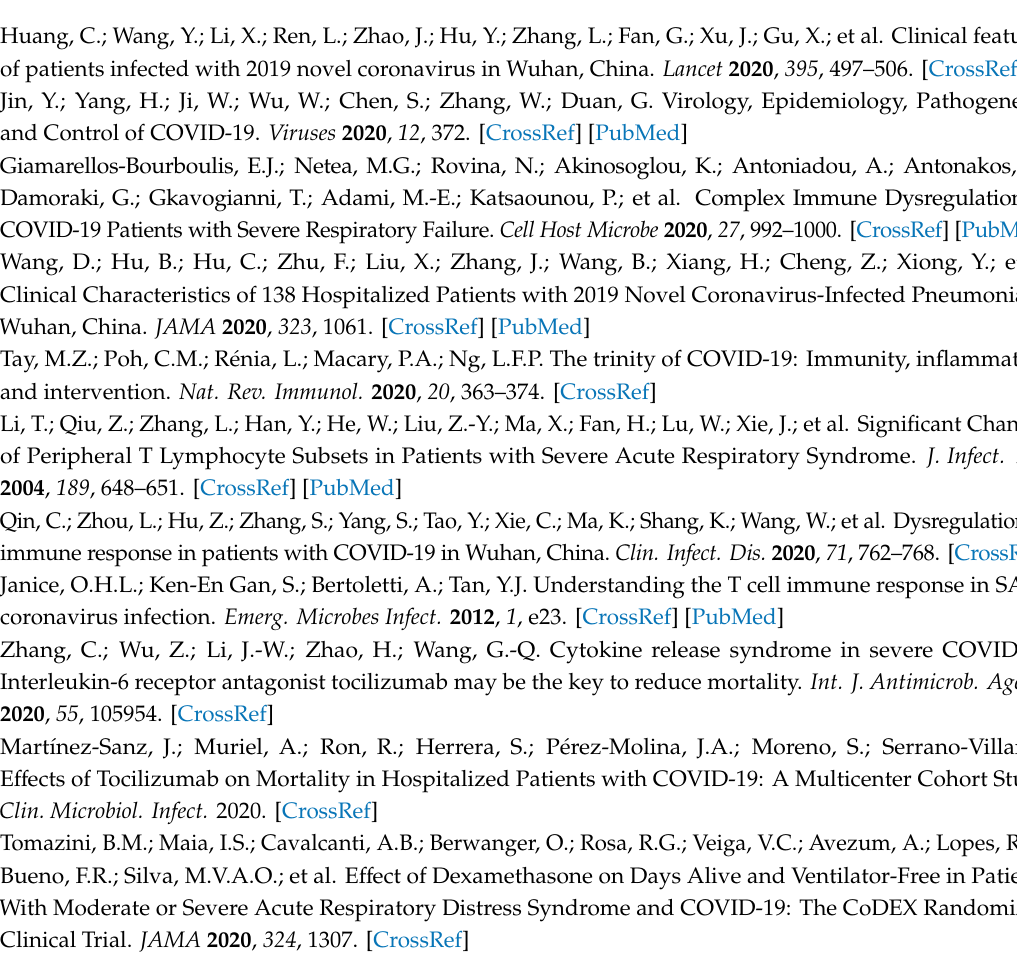
probabilities derived from a logistic regression model fitted to disease evolution (Non-critical vs. Critical) that included CD4 MFI and CD3 + CD4 + T cells as explanatory variables. Probabilities were estimated under a leave-one-out cross-validation procedure to avoid model over-fitting. AUC intervals at 95% confidence were computed using bootstrap. Total accuracy, sensitivity, and specificity are displayed for the optimal threshold, which is defined as the ROC point closest to the top-left part of the plot (perfect sensitivity and specificity). Figure S4. Receiver Operating Characteristics (ROC) and their corresponding Area Under the Curve (AUC) for the prediction of COVID-19 clinical evolution using CD4 MFI and CD3 + CD4 + T cell and CD4 +/ CD8 + ratio simultaneously. ROC curve was computed on the probabilities derived from a logistic regression model fitted to disease evolution (Non-critical vs. Critical) that included CD4 MFI, CD3 + CD4 + , and CD4 +/ CD8 + ratio as explanatory variables. Probabilities were estimated under a leave-one-out cross-validation procedure to avoid model over-fitting. AUC intervals at 95% confidence were computed using bootstrap. Total accuracy, sensitivity, and specificity are displayed for the optimal threshold, which is defined as the ROC point closest to the top-left part of the plot (perfect sensitivity and specificity). References [33–38] are cited in the Supplementary